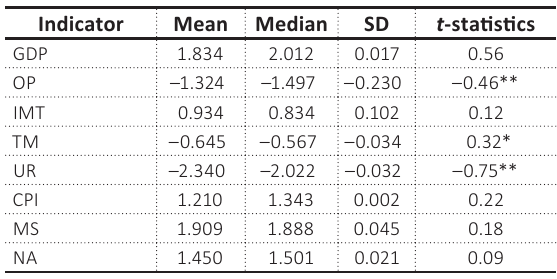
Table 4. Mean, median, standard deviation, and